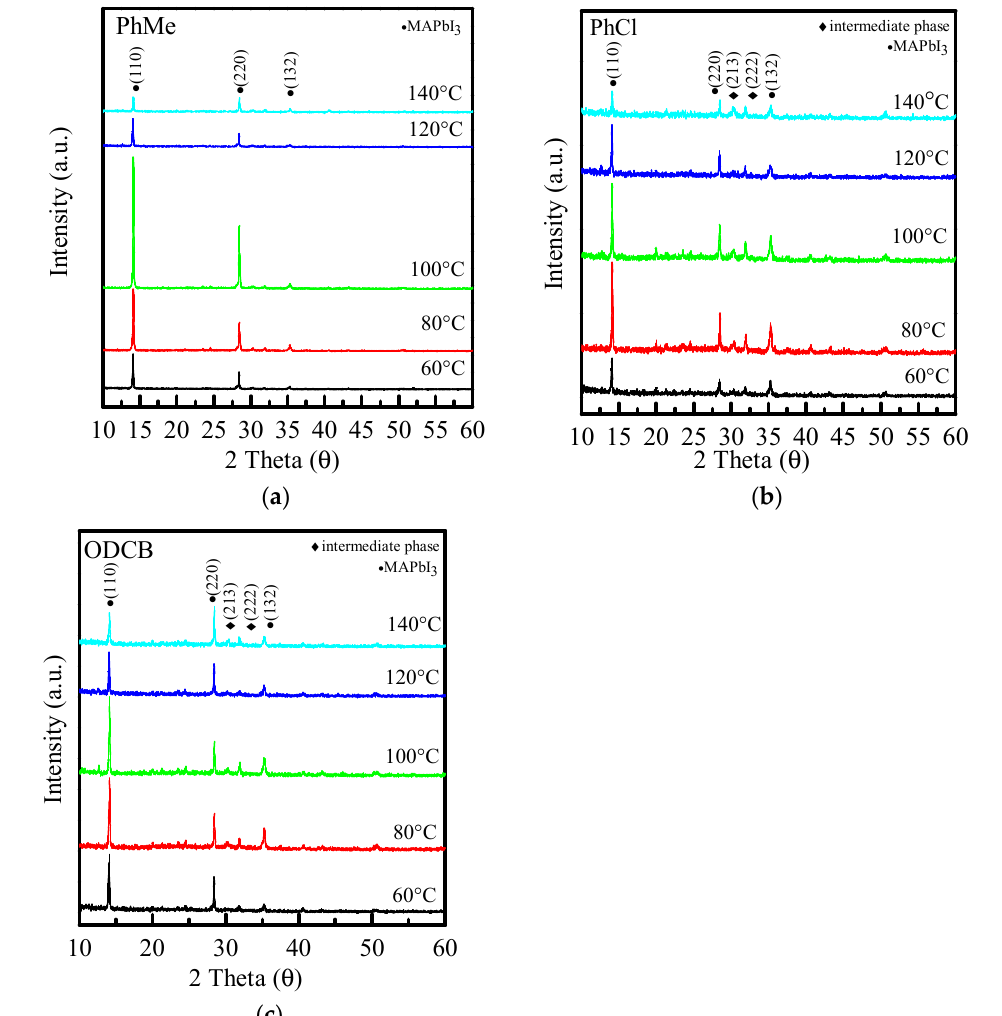
Figure 5. XRD diffraction patterns of (a) PhMe, (b) PhCl, and (c) ODCB at different re-annealing temperatures, respectively.